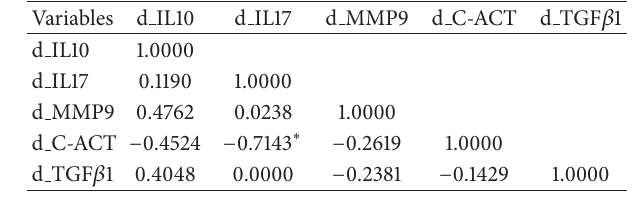
Table 6: Correlation analysis between changes of C-ACT scores and the levels of IL-10, IL-17, TGF- 𝛽 1, and MMP-9 in TCM group.